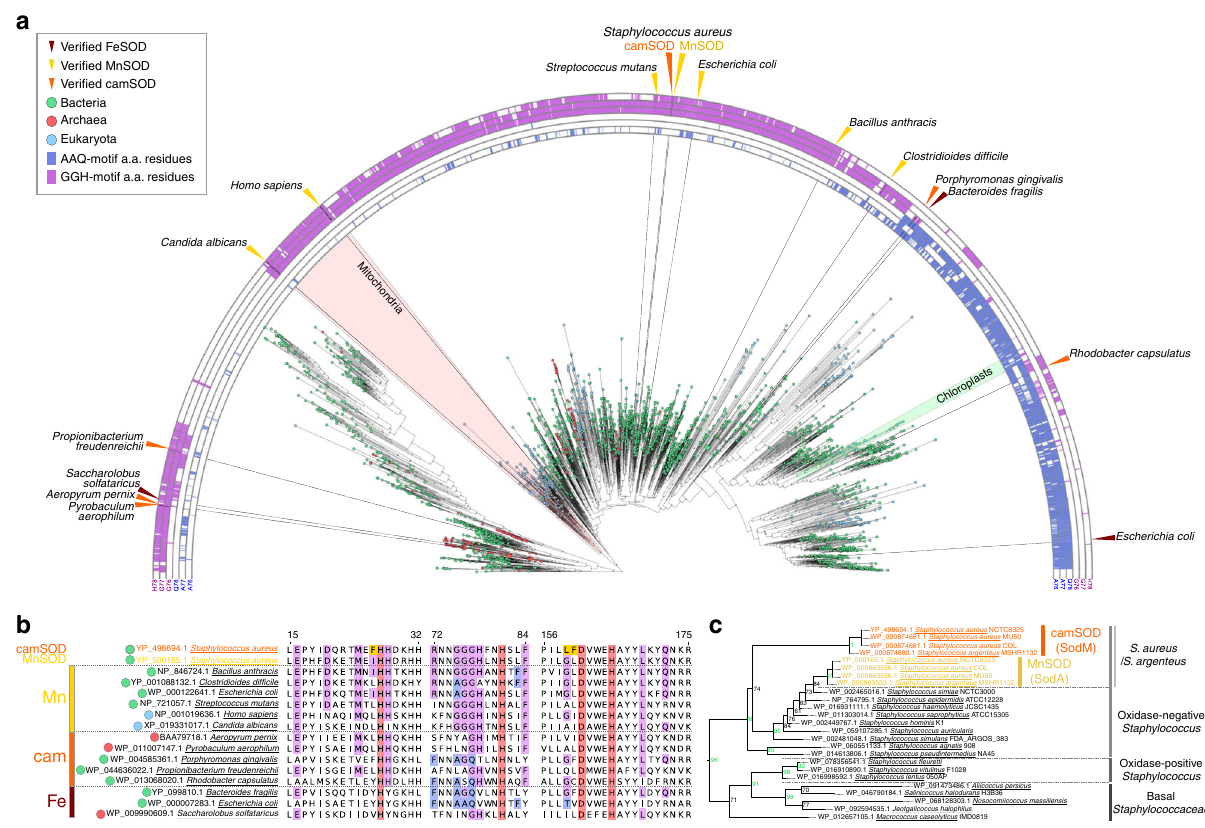
Fig. 4 S. aureus camSOD evolved from a manganese-speci fi c predecessor. a Amino acid correlation (de fi ned in the text as the AAQ group, blue, and the GGH group, magenta) and unrooted maximum likelihood phylogenetic tree based on alignment of amino acid (a.a.) sequences of 2691 Mn/Fe SOD homologs from bacteria (green circles), eukaryotes (sky blue circles), and archaea (red circles). Known metal-speci fi cities of characterized enzymes (MnSOD = yellow, FeSOD = brown; camSOD = orange) are annotated with triangles. b Fragment of the alignment of selected SOD sequences of known metal speci fi city, with the metal-binding residues (red) and three residues in S. aureus camSOD (yellow) that were targeted for mutagenesis shown. Groups 1 and 2 of coevolving residues, identi fi ed using amino acid correlation analysis, were mapped onto the alignment, illustrating the GGH or AAQ motifs and associated correlated amino acids. The correlated residues, biological origin and metal speci fi city are indicated using the color scheme described in a , and sequence numbering is based on the S. aureus SODs. c Sub-tree extracted from the SOD tree in panel a containing all identi fi ed staphylococcal SOD sequences. Support values correspond to maximum likelihood bootstrap values from 100 rapid bootstrap replicates, with values >90 shown in green. The scale bar indicates number of substitutions per site. Macrococcus and the oxidase-positive staphylococci form an out-group to a strongly supported grouping of oxidase-negative staphylococci, including S. aureus , consistent with published Staphylococcaceae phylogenies 19,40,41 . Within the oxidase- negative staphylococci, all MnSOD (yellow) grouped together while camSOD homologs (orange) formed an out-group to the